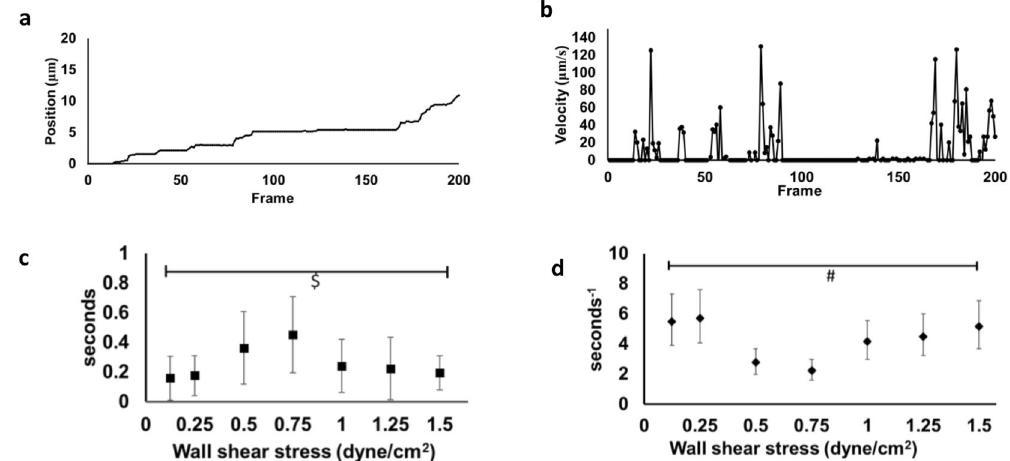
Figure 3. DBTA probe adhesion to signet ring cell colon carcinoma (SRCC) tissue is force-dependent. (a) Position profile of a P-selectin DBTA probe rolling on a tissue section (SRCC 48 y/o case) at 0.75 dyne/cm 2 . Video frame rate = 175 fps (Supplementary Video S8). (b) Velocity profile of the P-selectin DBTA probe tracked in ( a ). ( c ) Increasing levels of applied force initially increased then decreased the lifetime of P-selectin DBTA probe adhesion to SRCC tissue. Data shown are mean adhesion duration in seconds ± SD of 30 separate pauses at each wall shear stress collected in a 100 μ m × 100 μ m region. $ F = 12.59 > F 0.01, 6,273 = 2.80 (d ) Increasing levels of applied force initially decreased then increased the off-rate (k off ) of P-selectin DBTA probe from the SRCC tissue. Data shown represent the estimation of P-selectin DBTA probe k off using the method of maximum likelihood 48 from 30 separate pauses at each wall shear stress. Error bars represent 95% CI. # Levene’s test = 4.0818 (equivalent to P =